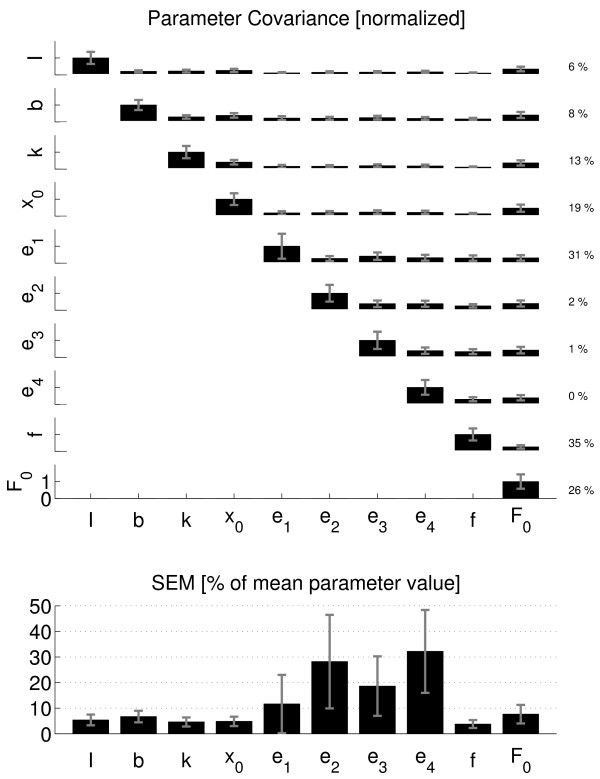
Parameter covariance. Covariance matrix P (top) and SEM values (bottom) of all estimated model parameters. Only the upper part of P is shown because of its symmetry. For normalization, see Method Section. Averages over all conditions and subjects (solid bars) ± 1 s.d. (grey error bars). The auto-covariance is on the diagonal of P. The off-diagonal terms of P are the relative cross-covariances between two different corresponding parameters. Percentages at the right are measures of interdependence, i.e. the number of times the auto-covariance was smaller than any of the corresponding cross-covariance values. The SEM is equal to the square root of the auto-covariance, divided by the corresponding mean parameter value.